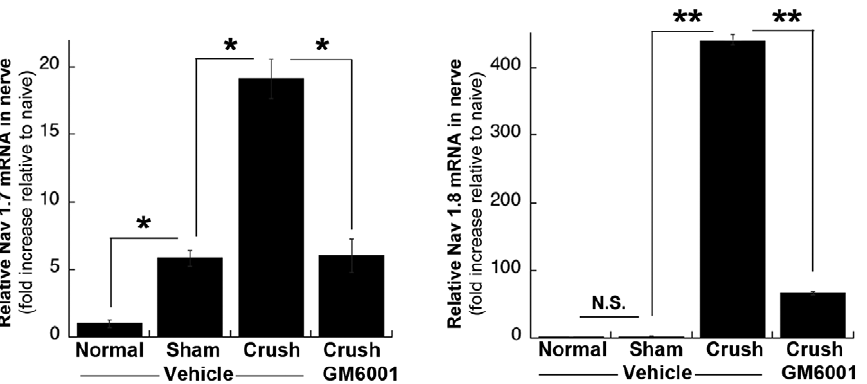
Figure 7. MMPi therapy blocks Na v 1.7 and 1.8 channel induction in nerve. Taqman qPCR for Na v 1.8 and 1.7 in normal or crushed (day 5) rat sciatic nerve normalized to GAPDH. GM6001 or vehicle was administered i.p. immediately and then daily at days 1–5 after crush. The mean fold increase 6 SEM to normal nerves (*, p , 0.05; **, p , 0.01, ANOVA, Tukey’s post-hoc test of n=6/group). NS, not significant.